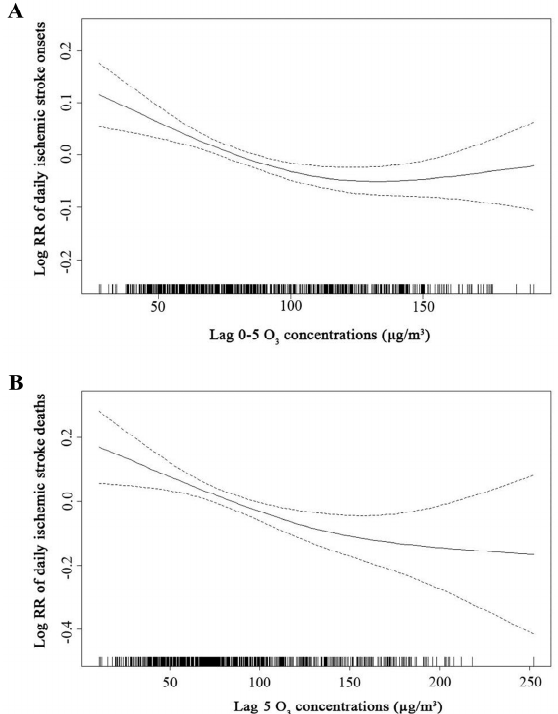
Figure 3. The exposure-response relationships of O 3 levels with ischemic stroke onsets ( A ) and deaths ( B ) at selected lag days (lag 0–5 for ischemic stroke onsets and lag 5 for daily ischemic stroke deaths) in single-pollutant models in Changzhou, 2015–2016. The data was expressed as mean with 95% confidence interval. O 3 indicates ozone.